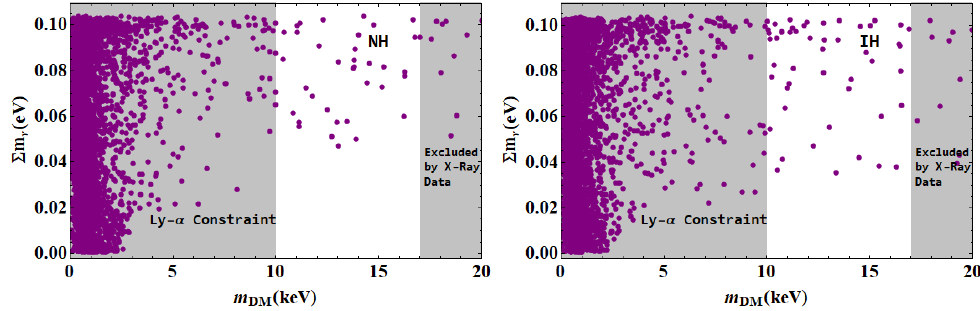
Figure 18 . Sum of light neutrino masses as a function of mass of DM for both normal hierarchy as well as inverted hierarchy.